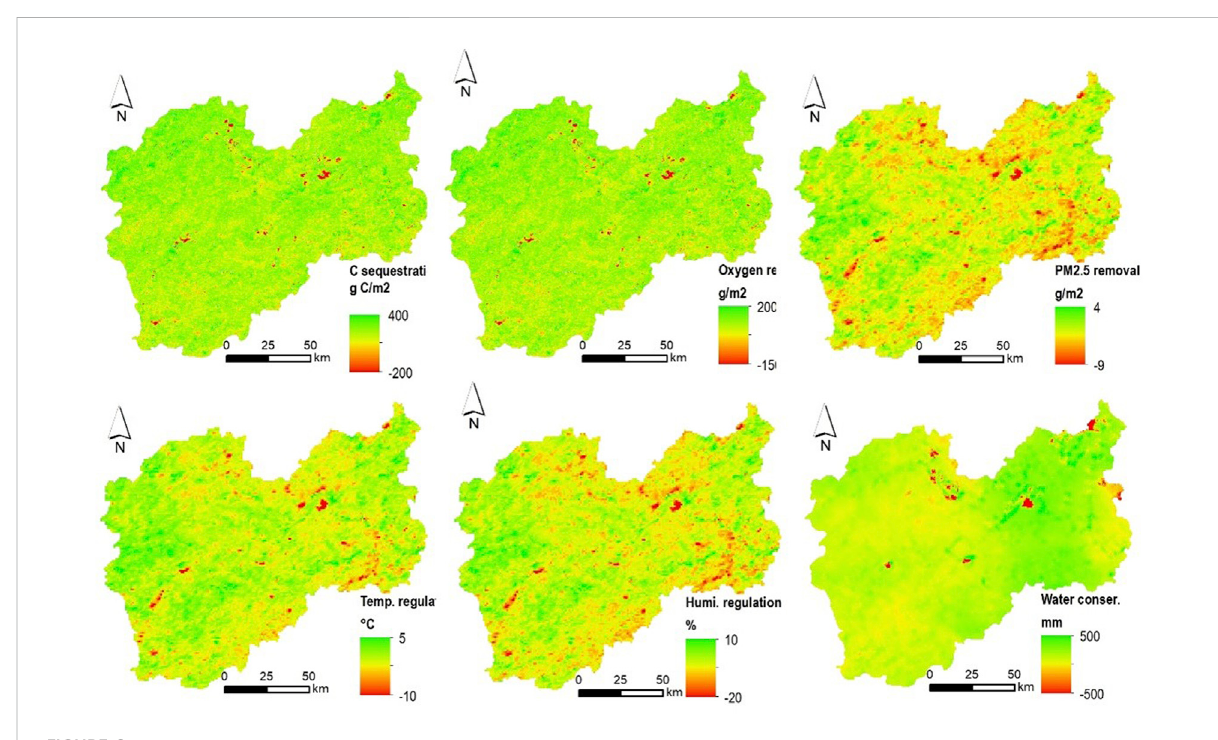
FIGURE 6 Changes in spatial pattern of ecosystem services in Lishui City from 2009 to